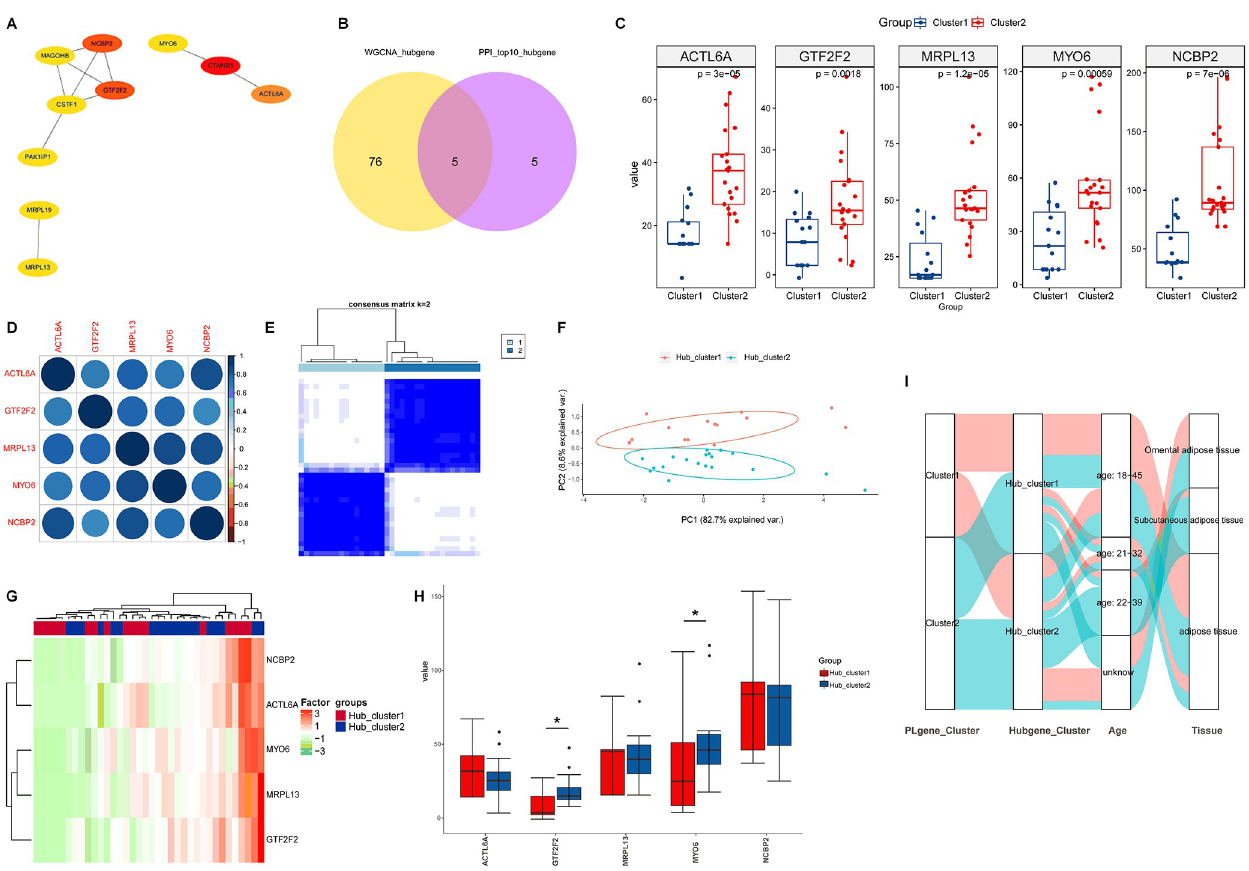
Fig 3. Grouping based on hub genes of PCOS. (A) Top10 hub genes were identified and PPI networks were established with Cytoscape. (B) Venn diagram for the overlapping genes between the above 10 hub genes and hub genes for the key modules. (C) The expression comparison of the five overlapped hub genes between cluster1 and cluster2. (D) The relationship among these overlapped hub genes were shown. (E) A relative stable partitioning of the samples at k = 2 in consensus heatmap. (F) In PCA analysis, the symbols represent the gene expressed differently in hub_cluster1 and hub_cluster2. (G) The expression heatmap of these overlapped hub genes in hub_cluster1 and hub_cluster2. (H) The expression comparison of the five overlapped hub genes between hub_cluster1 and hub_cluster2. (I) Sankey diagram for the links among the preterm labor or labor related gene clusters, hub gene clusters, age subgroups and adipose tissue subtypes of